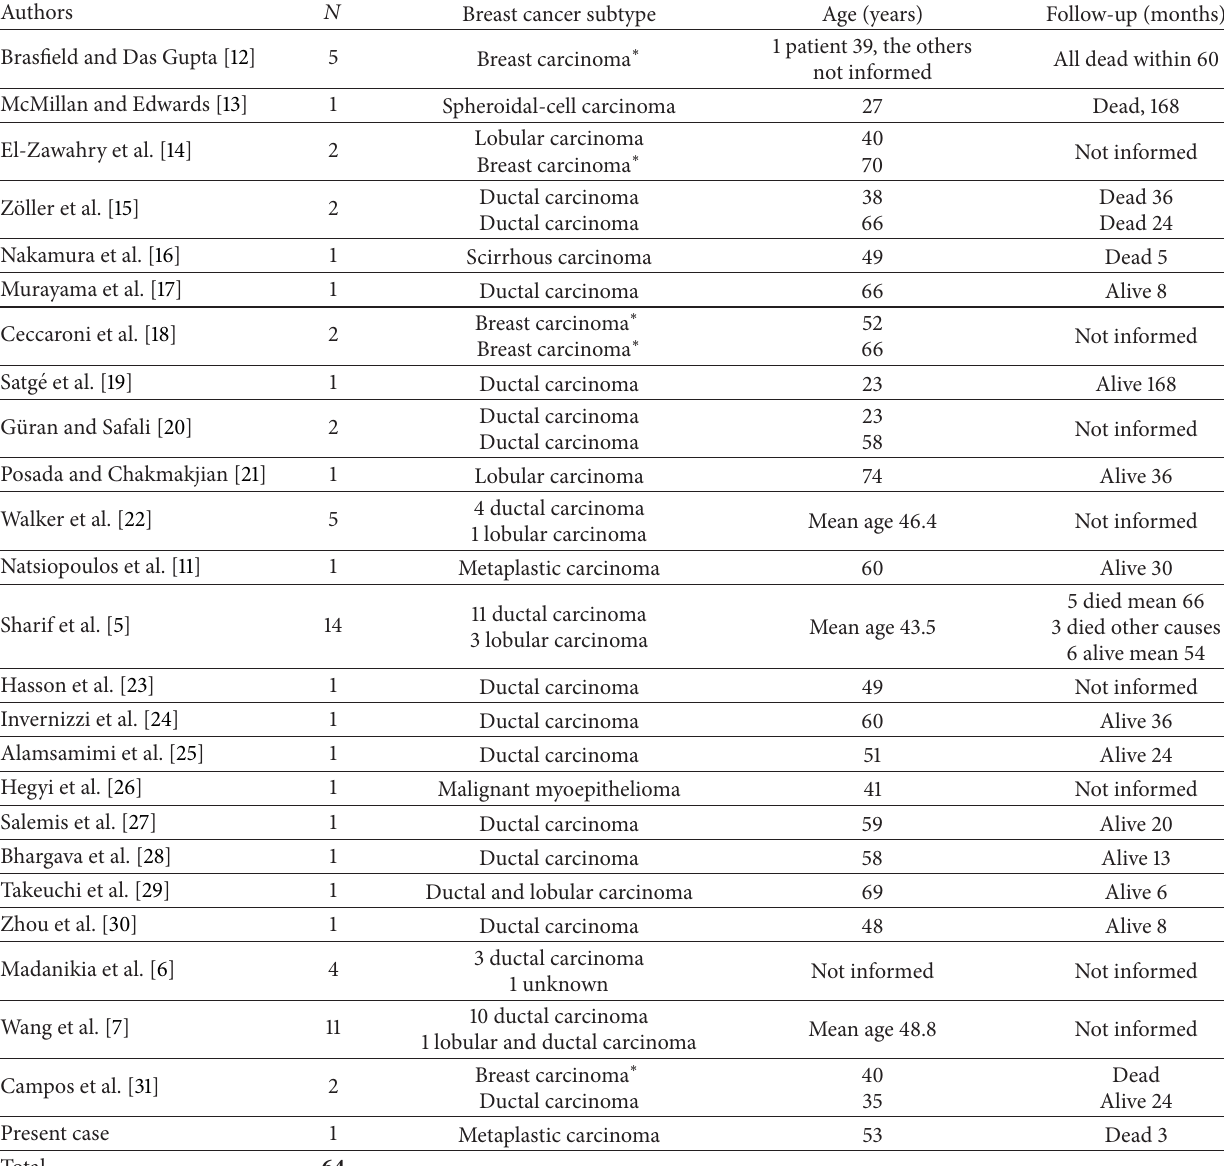
Table 2: Total of patients with NF1 who developed breast carcinoma considering only English language